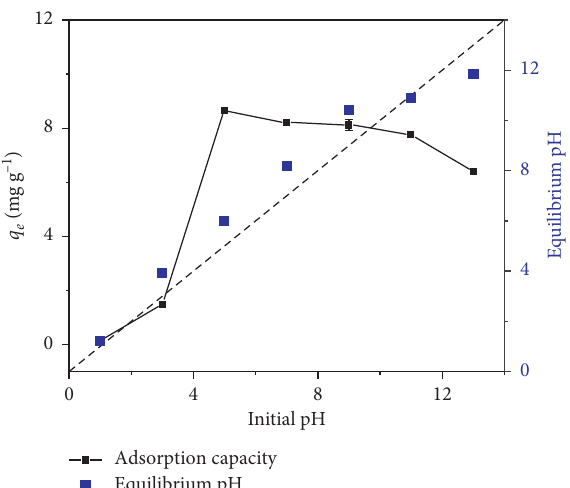
Figure 7: EffectofpHonthephosphorusadsorptionbehaviorandfinal pH after reaching equilibrium ( t � 10min, adsorbent dosage � 1g · L − 1 , 120rpm, initial phosphorus concentration � 10mg · L − 1 , and 25 ° C).